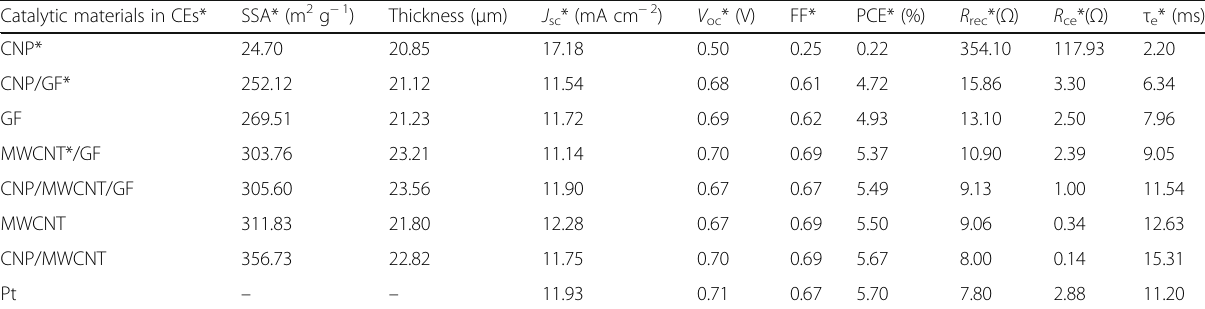
Table 1 Photovoltaic performance of DSSCs based on different catalytic materials stacked on the surface of CEs of DSSCs Catalytic materials in